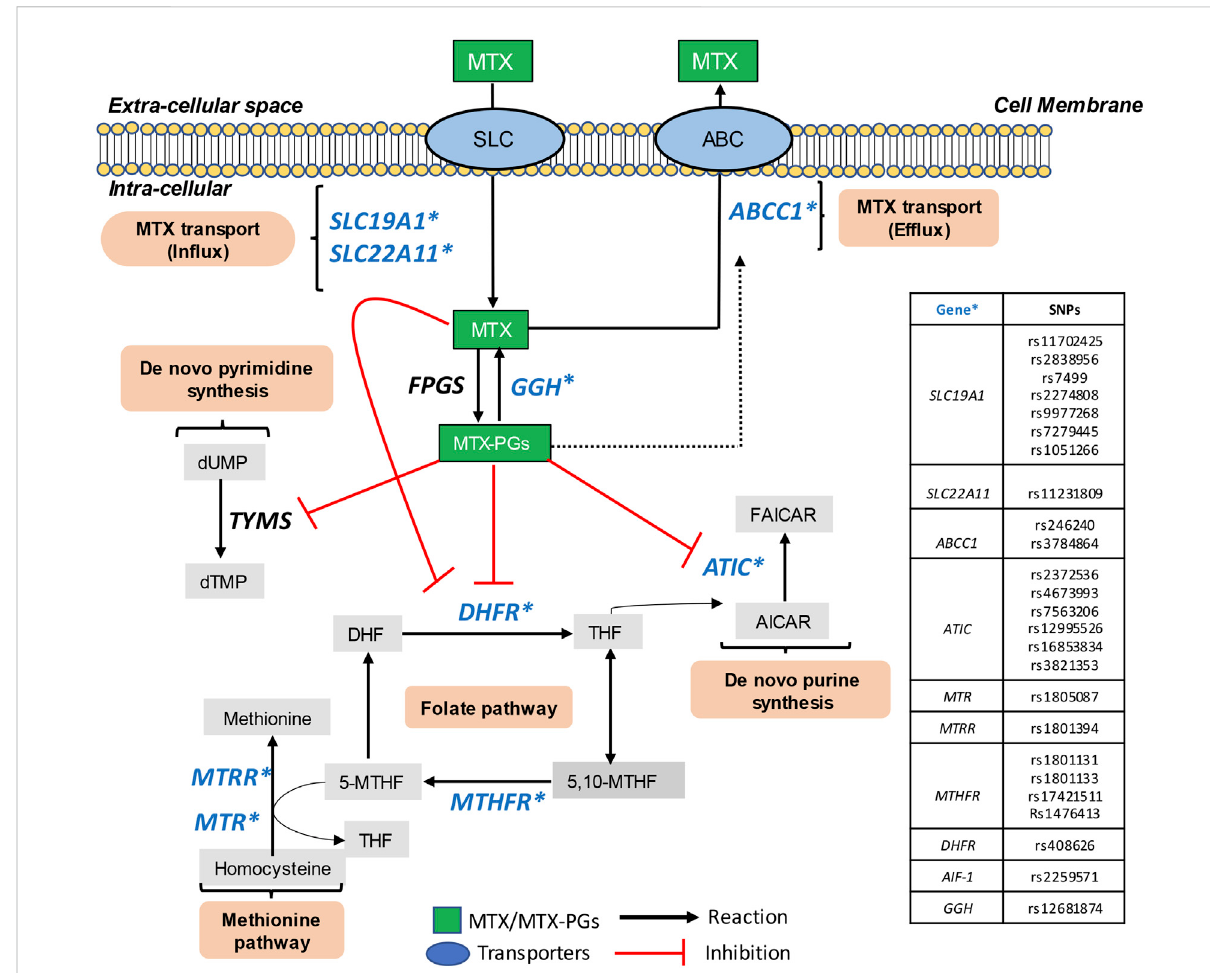
FIGURE 1 Metabolic pathways ofintracellular metabolism of MTX.MTX, Methotrexate; SLC, solute carrier; ABC, ATP-binding cassette transporters; FPGS, folylpoly- γ -glutaminase synthetase; GGH, γ -glutamyl hydrolase; MTX-PGs, methotrexate polyglutamate; DHFR, dihydrofolate reductase; DHF, dihydrofolate; THF, tetrahydrofolate; 5,10-MTHF, methyltetrahydrofolate cyclohydrolase; 5-MTHF, L-methylfolate; MTR, methionine synthase; MTRR, methionine synthase reductase; MTHFR, methylenetetrahydrofolate reductase; TYMS, thymidylate synthase; dUMP, deoxyuridine monophosphate; dTMP, deoxythymidine monophosphate; ATIC, 5-aminoimidazole-4-carboxamide ribonucleotide formyltransferase; AICAR, 5- aminoimidazole-4-carboxamide ribonucleotide; AMP, adenosine monophosphate; FAICAR, 5-formylaminoimidazole-4-carboxamide ribonucleotide; IMP, inosine monophosphate; AMP, adenosine monophosphate; AIF-1, allograft in fl ammatory factor 1 and GGH, gamma-glutamyl hydrolase. SNPs included in the current study are marked with blue font and star